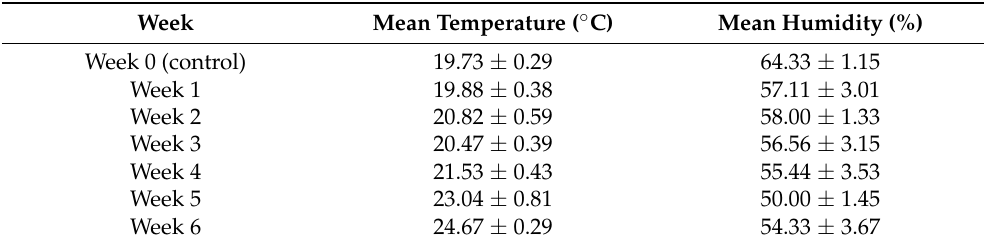
Table 2. Weekly mean temperature and humidity in the company warehouse. Results are expressed as the mean of the three replicates ±